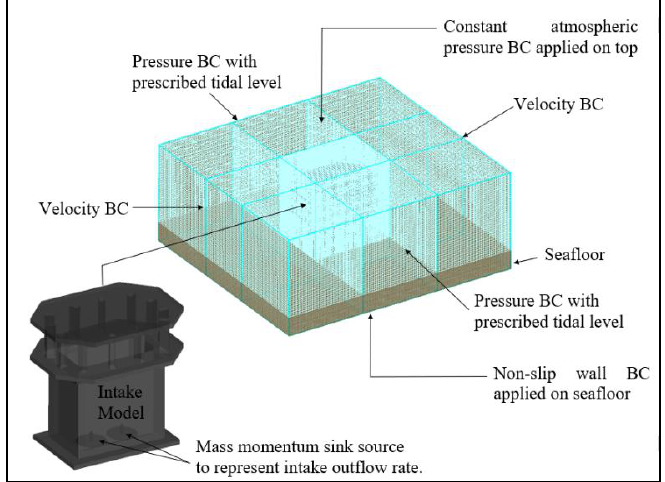
Figure 5. Model boundary conditions.